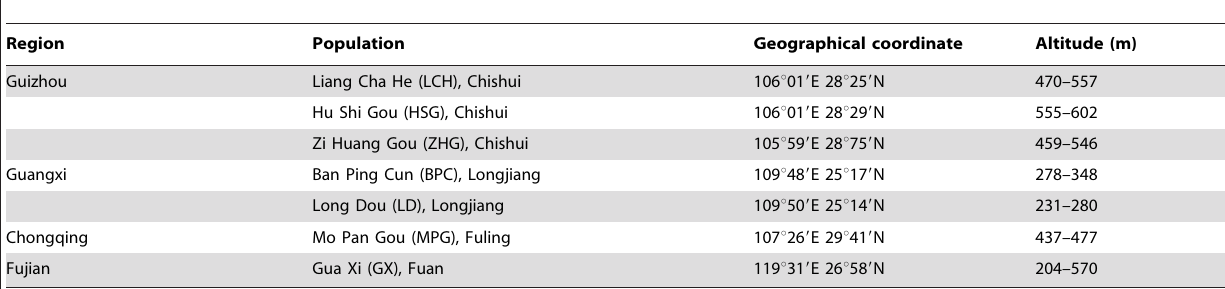
Table 2. List of code, location, and altitude of the seven Alsophila spinulosa populations included in this study.